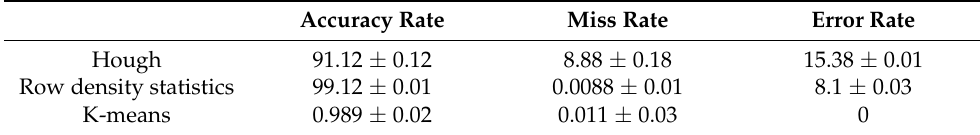
Table 2. Experimental results.